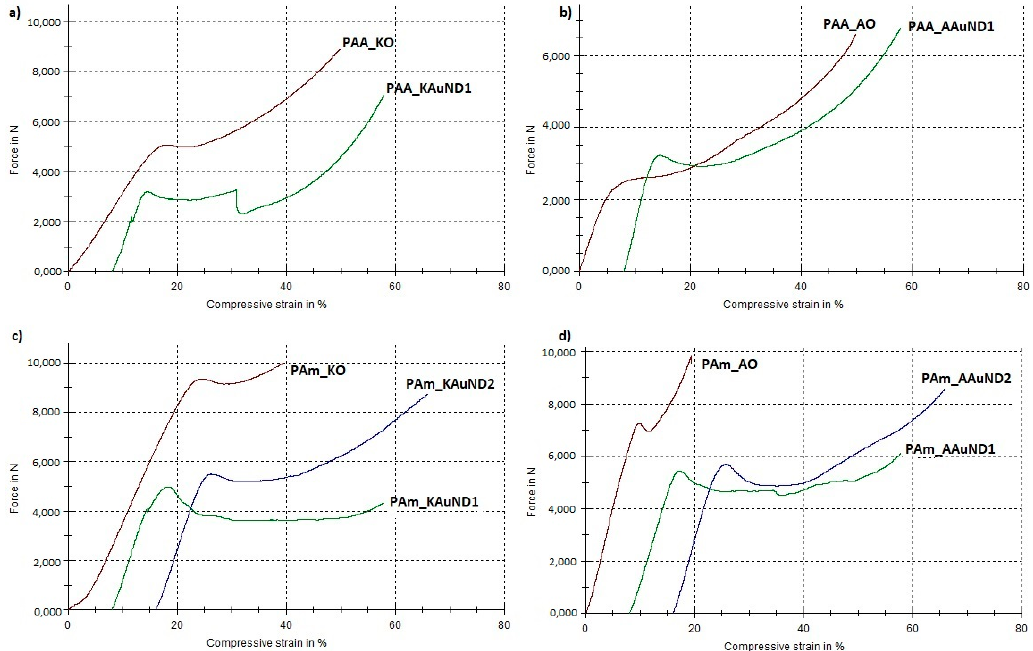
Figure 8 . Load-compressive strain curves for tested specimens: ( a ) PAA_KO and PAA_KAuND1; ( b ) Figure 8. Load-compressive strain curves for tested specimens: ( a ) PAA_KO and